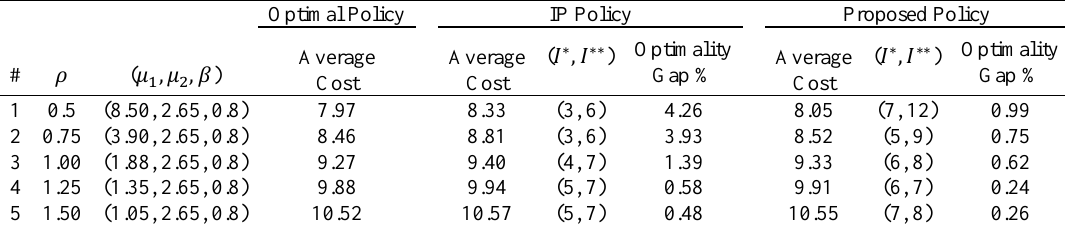
Table 9. Performances of the Alternative Policies with IFR distribution, s=5 and K=0 Optimal Policy IP Policy